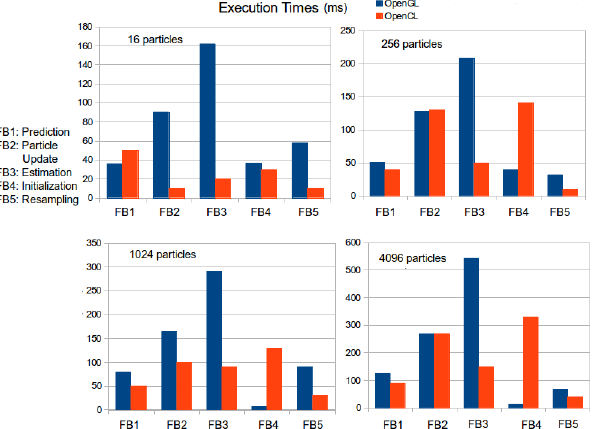
Figure 2. Processing time comparison of the di ff erent functional blocks between the GPGPU implementations using OpenCL, OpenGL